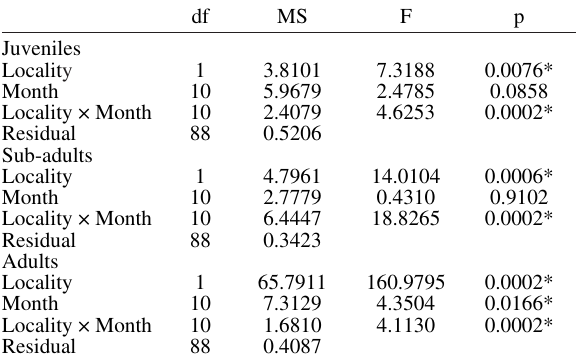
Table 4. – Results of two-factor ANOVA testing for differences in the abundance of individuals between localities (fixed factor) and months (random factor). *, significant for p<0.05. df